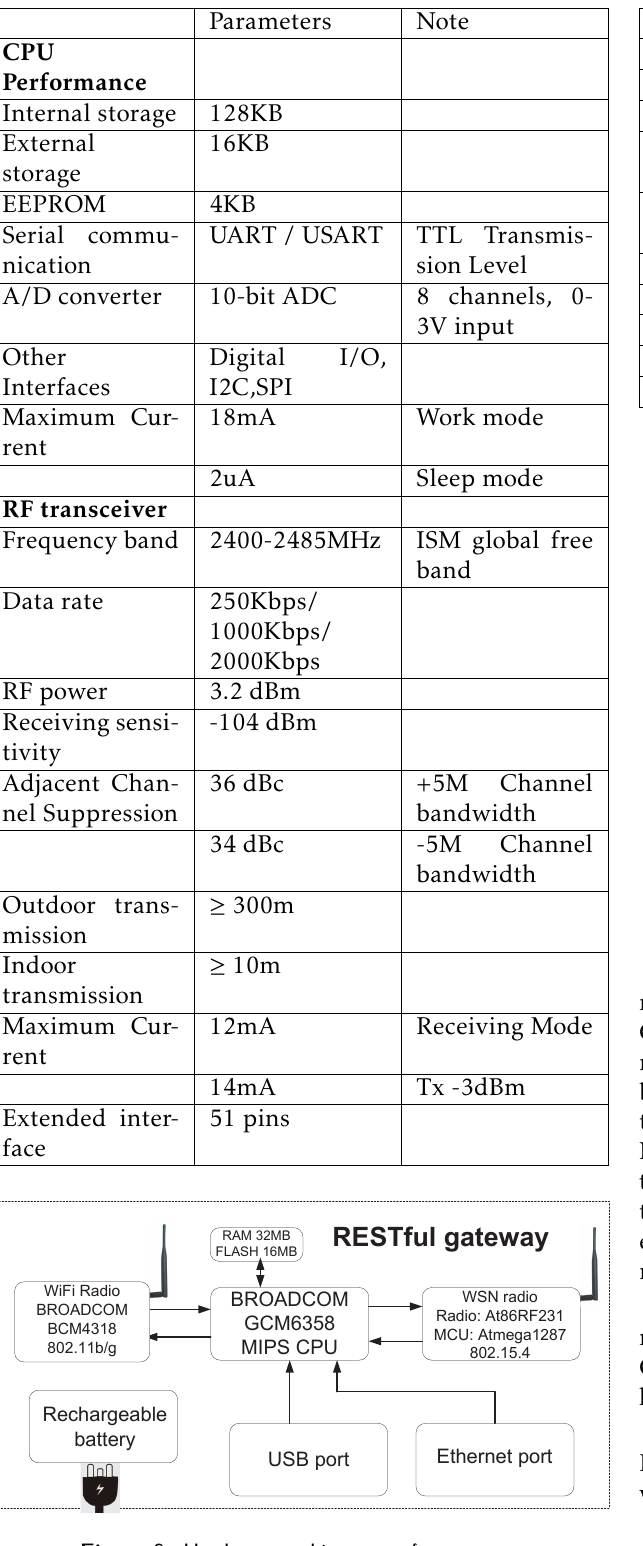
Figure 6. Hardware architecture of gateway